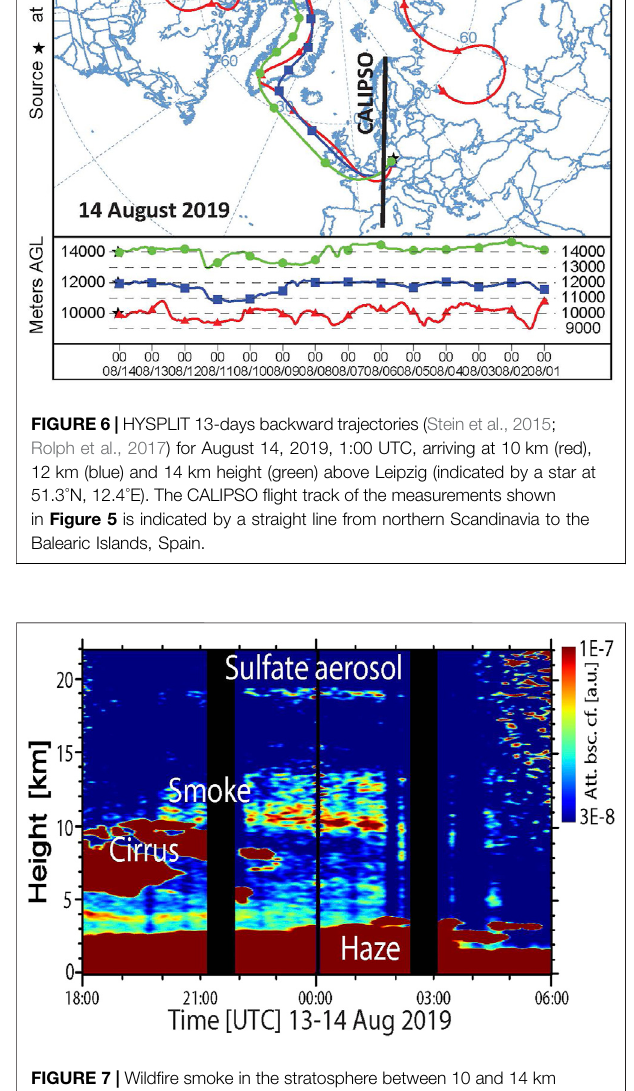
FIGURE 7 | Wild fi re smoke in the stratosphere between 10 and 14 km height and a volcanic sulfate aerosol layer at 19 – 20 km height observed with ground-based lidar over Leipzig, Germany, on August 13 – 14, 2019. Anthropogenic haze as well as wild fi re smoke polluted the troposphere up to 7 – 8 km height. The attenuated backscatter coef fi cient at 1,064 nm (in arbitrary units) is shown. Black columns indicate missing observations (lidar calibration